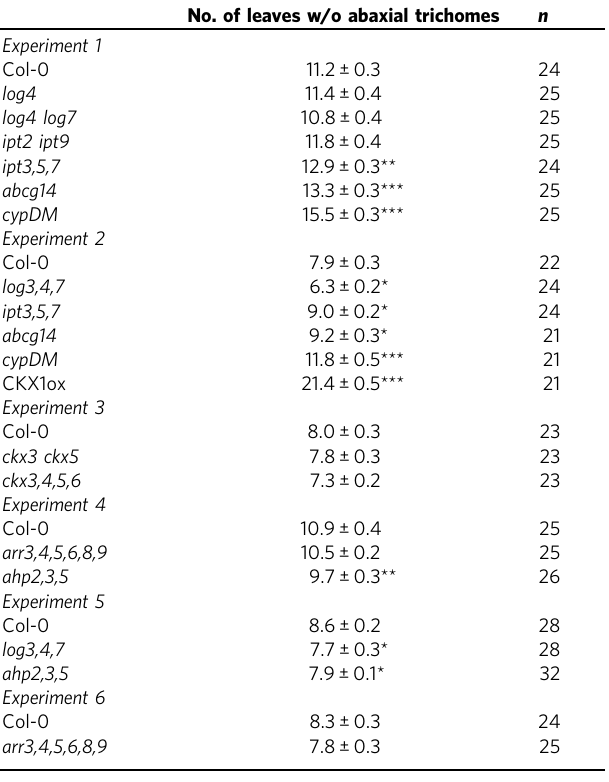
Values indicate the mean number of leaves without abaxial trichomes ± SEM. Asterisks indicate signi fi cant differences compared to the wild type of the respective experiment, as calculated by Kruskal – Wallis test (experiments 1 – 5) or Mann – Whitney test (experiment 6) (* q <0.05; ** q <0.01; *** q <0.001). Exact p -values and q -values are included in the Source Data fi les.